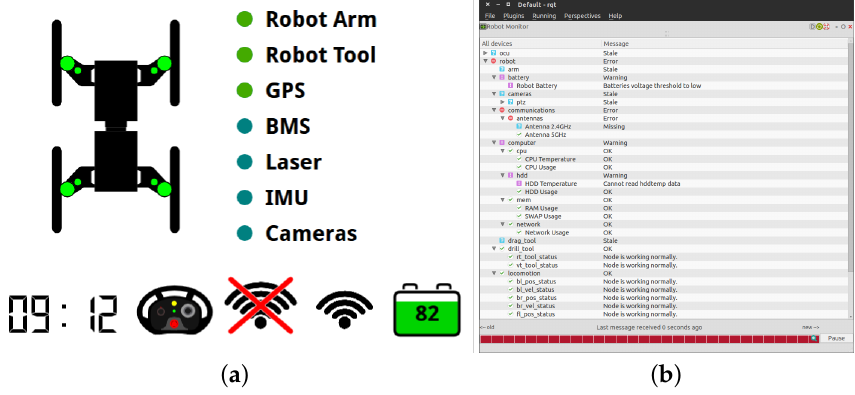
Figure 13. The diagnostic tool. ( a ) Graphical summary of the system’s health; ( b ) detailed diagnostic information. In this case, the system is reporting an issue related to one of the